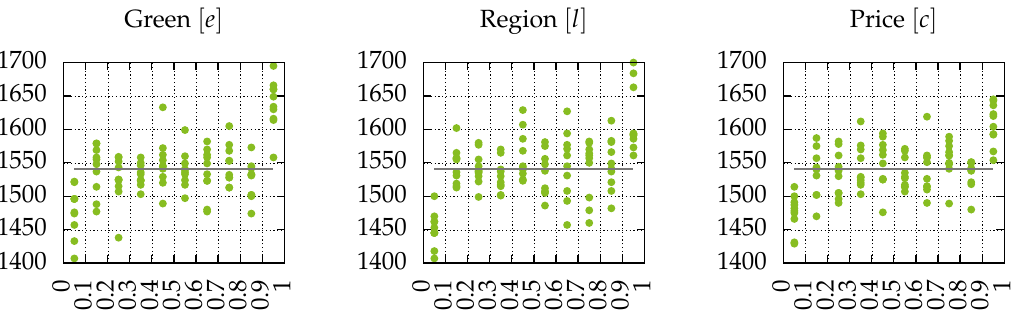
Figure 8. Uniform distribution of consumer